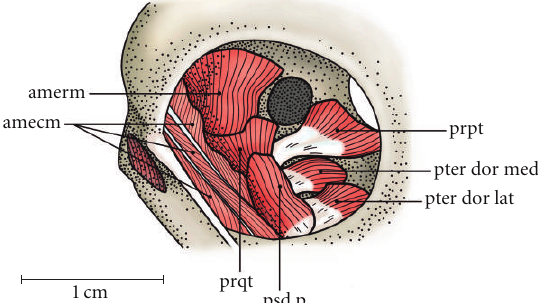
Figure 6: An oblique deep view of the jaw muscles of Blythipicus rubiginosus. amecl: adductor mandibulae externus caudalis medialis; amerm: adductor mandibulae externus rostralis medialis; prpt: protractor pterygoidei; prqt: protractor quadrati; psd p: